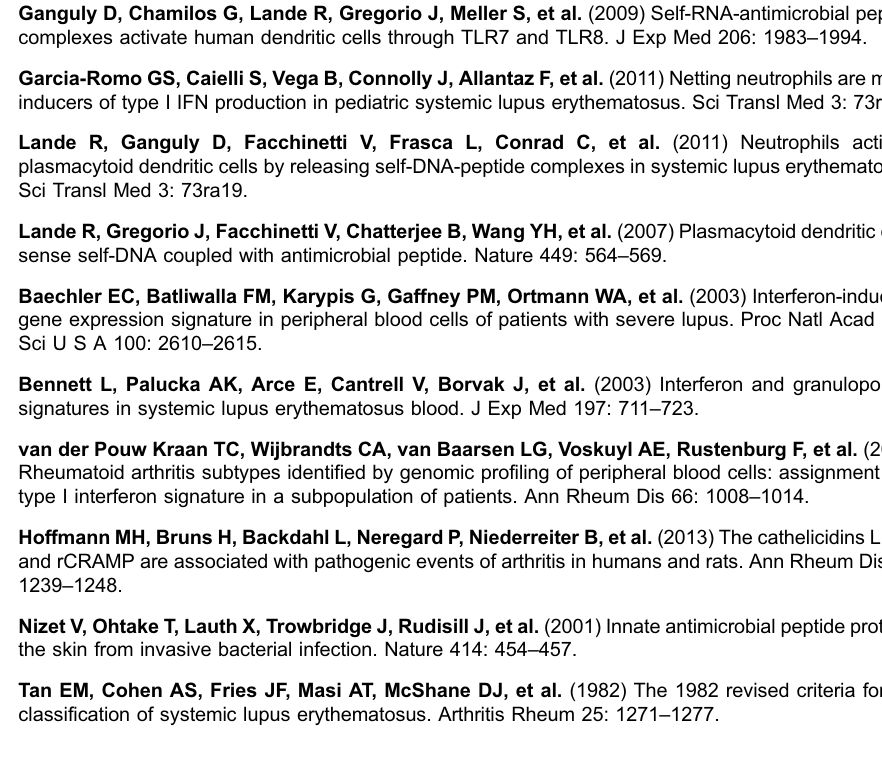
S1 Table. Serologic and clinical parameters and current treatment of individuals with SLE enrolled in the